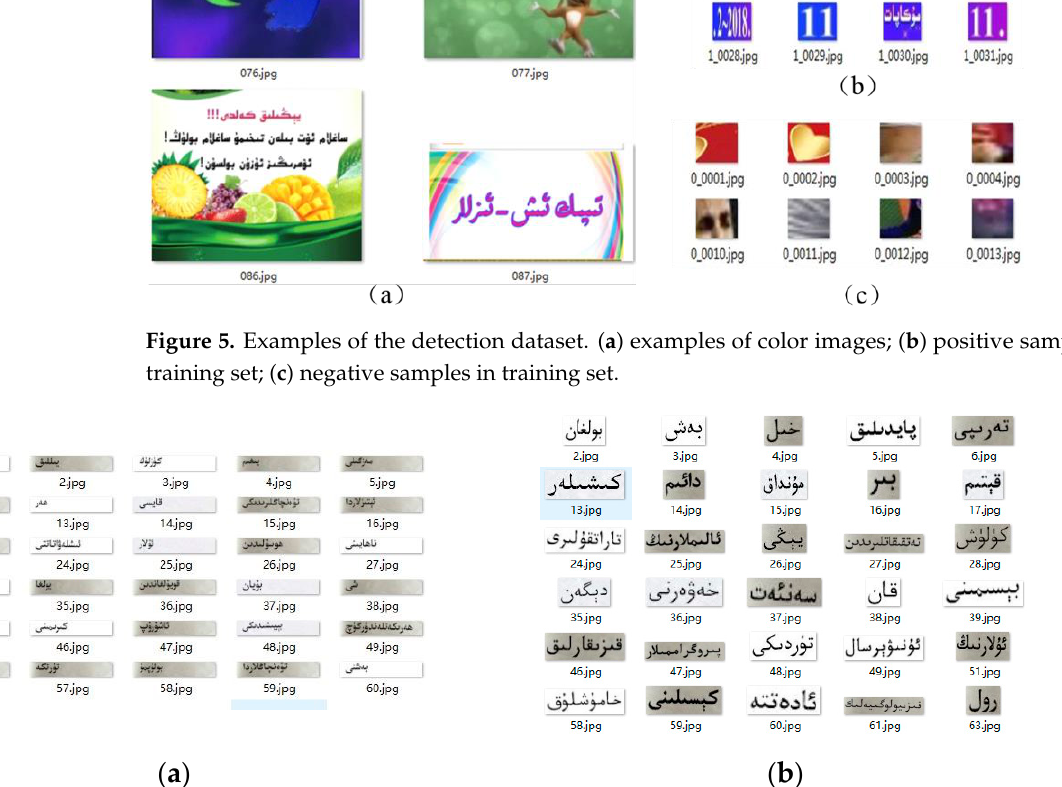
Figure 5. Examples of the detection dataset. ( a ) examples of color images; ( b ) positive samples in training set; ( c ) negative samples in training set.